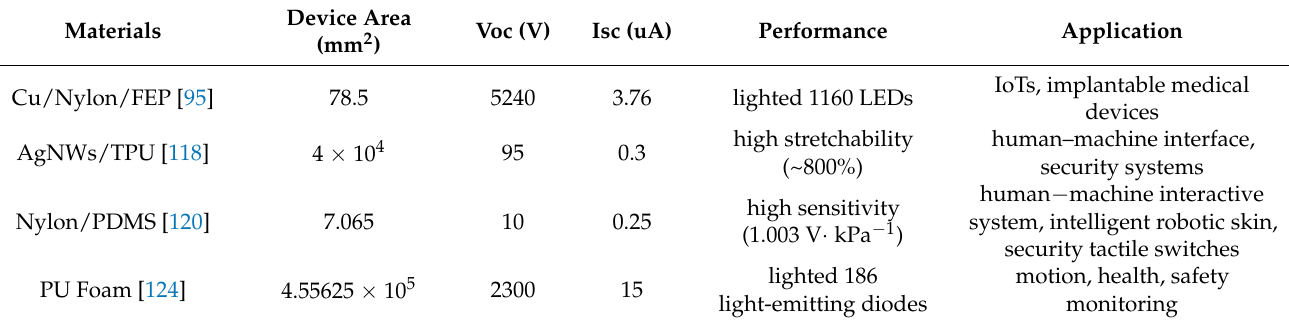
Table 2. Comparison of various self-powered sensors based on